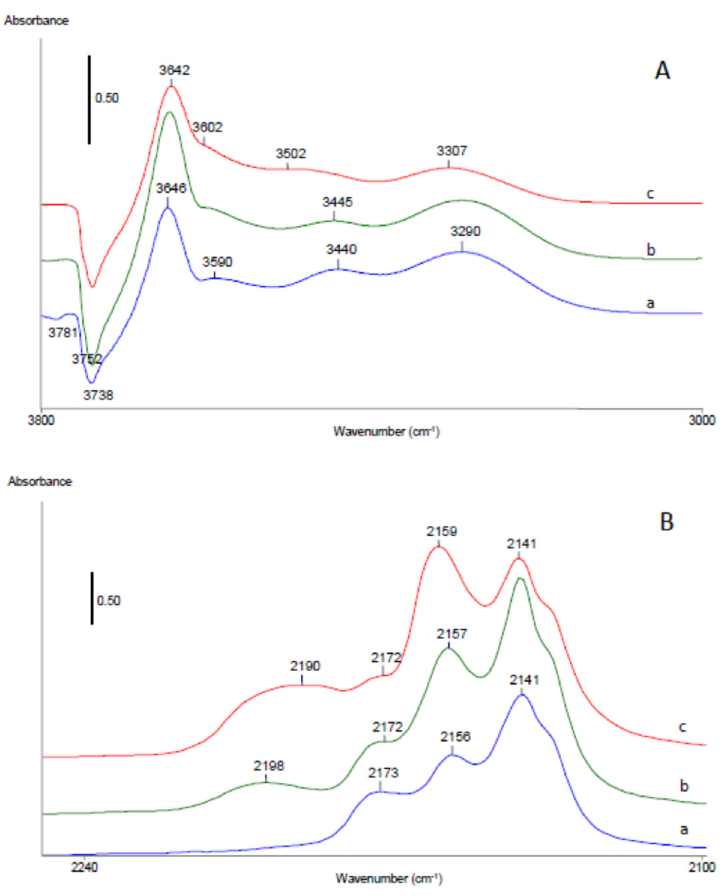
Figure 11. FTIR difference spectra in hydroxyl ( A ) and carbonyl ( B ) stretching ranges of HAlBEA, Co 1.0 HAlBEA(II), and Co 5.0 HAlBEA(II) after adsorption of CO (equilibrium pressure 133 Pa) at − 173 °C then evacuation to equilibrium CO pressure of 10 Pa.